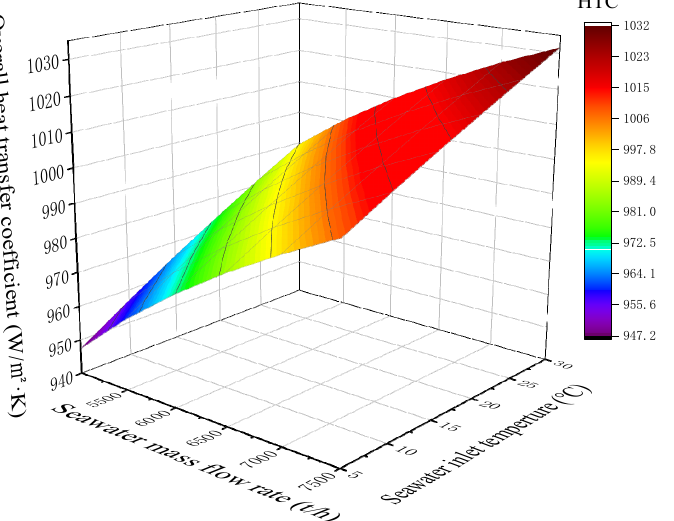
Figure 13. Overall heat transfer coefficient of the NG heater at different seawater mass flow rates and temperatures.